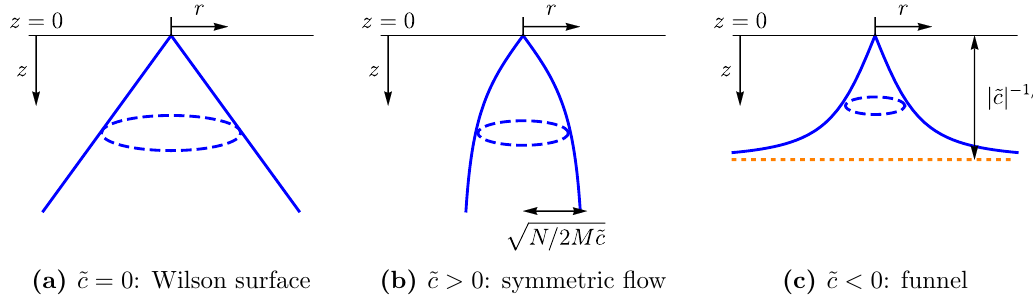
Figure 5. Cartoons of the di(cid:11)erent M5-brane embeddings wrapping an S 3 internal to AdS 7 . In each case the horizontal black line denotes the boundary of AdS 7 at z = 0, and the dashed blue line denotes the S 3 wrapped by the brane. (a) For ~ c = 0 the brane is dual to a symmetric representation Wilson surface. (b) For ~ c > 0 the brane describes a defect RG (cid:13)ow from a symmetric representation Wilson surface to a bundle of M2-branes. In terms of the coordinate r , as z ! 1 the radius of the p wrapped S 3 tends to a (cid:12)nite value r = N= 2 M ~ c , so the proper radius vanishes in this limit. (c) For ~ c = 0 the solution is a funnel, created by M2-branes ending on a Coulomb branch M5-brane at z = j ~ c j (cid:0) 1 = 2